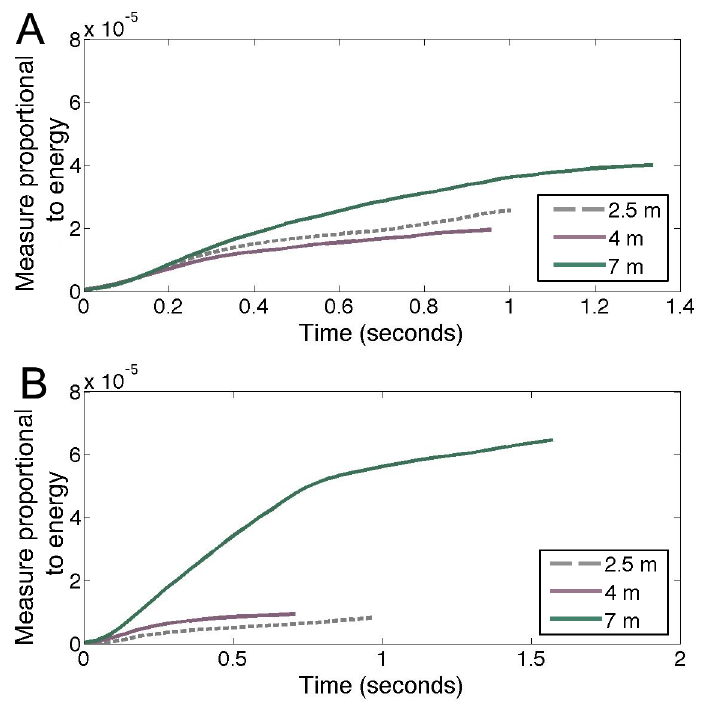
Figure 6. Cumulative energy over elapsed time for unpredictable targets (5a, top) and predictable targets (5b, bottom). Time was estimated based on the two-way-travel time plus a ‘‘lag’’ time of 30 ms. The vertical axis is (amplitude 2 6 time), which is a measure proportional to energy. This analysis further highlights the increased energy for the 7 m predictable target. For the predictable condition, the slope of the total energy versus time is much steeper than the other target distances, indicating a faster rate of source energy and therefore potential received information from the target echo.